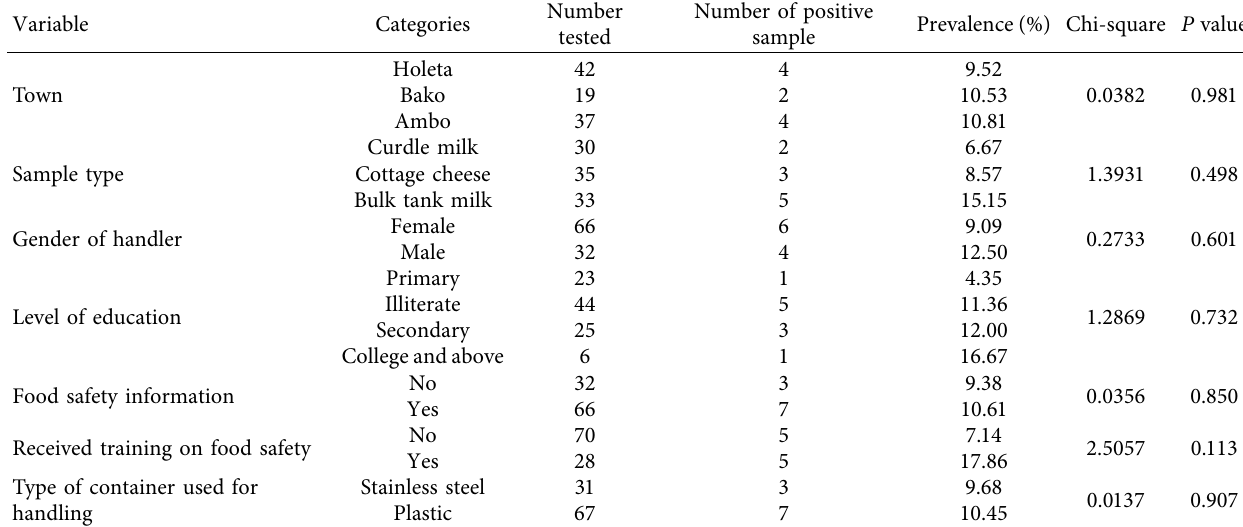
Table 5: Results of Chi-square analysis of the association between the prevalence of Listeria species in bulk tank milk, curdled milk, and cottage cheese and potential risk factors for contamination.